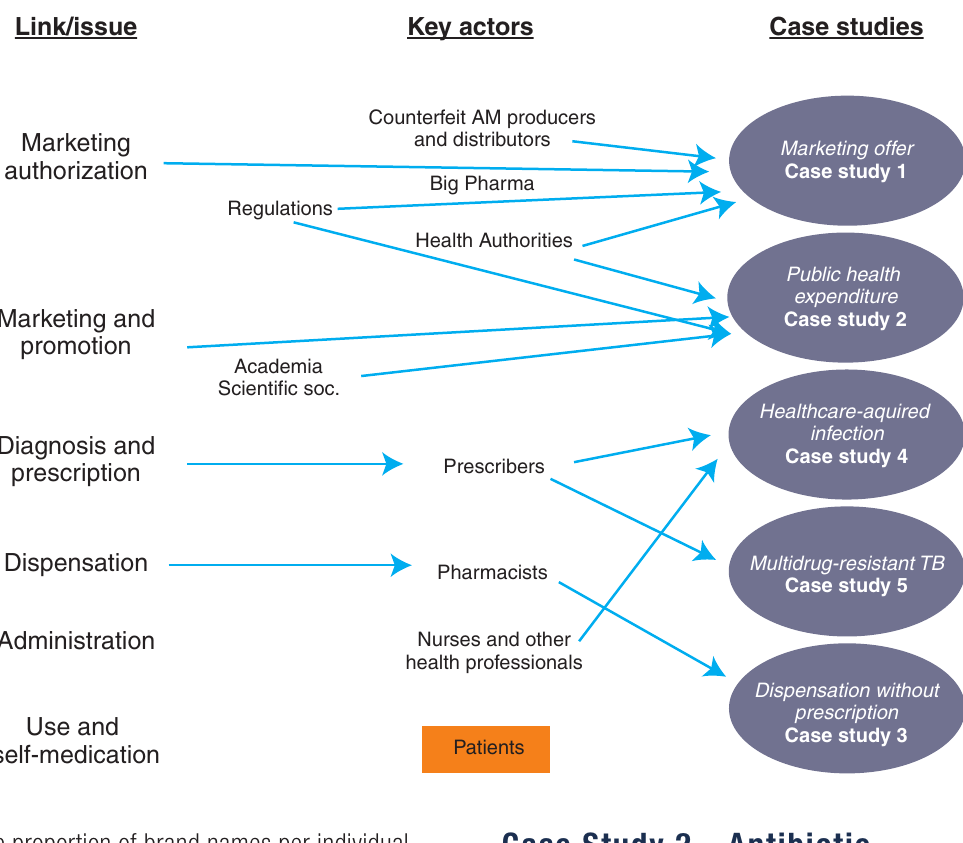
FIGURE A9.1. A Basic “Antimicrobial Use